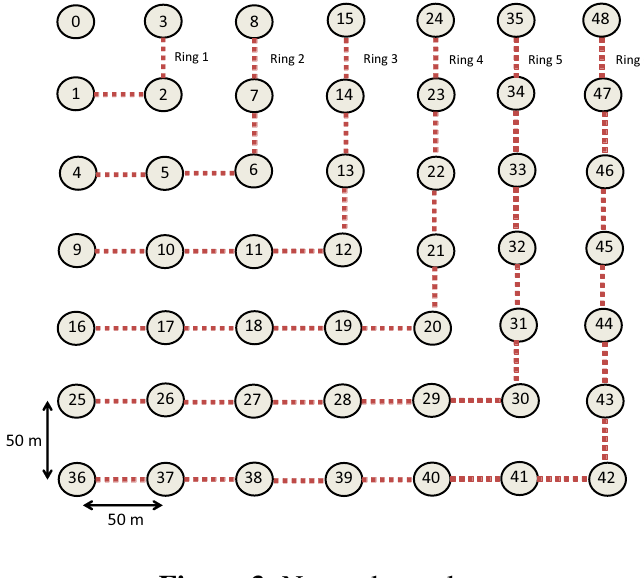
Figure 3. Network topology.